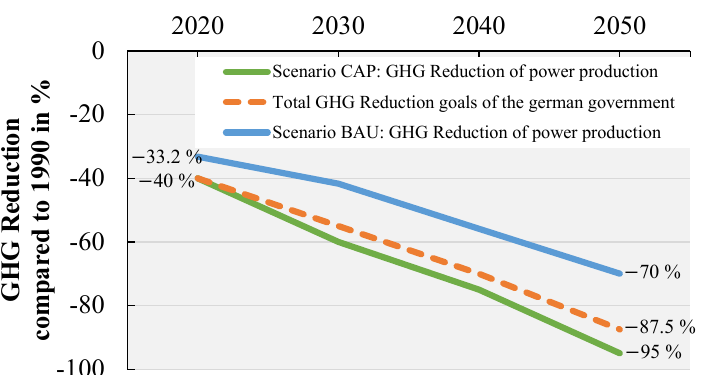
price for CO 2 (EU allowances) increases continuously to 150 € /t in 2050. These assumptions apply to both scenarios.